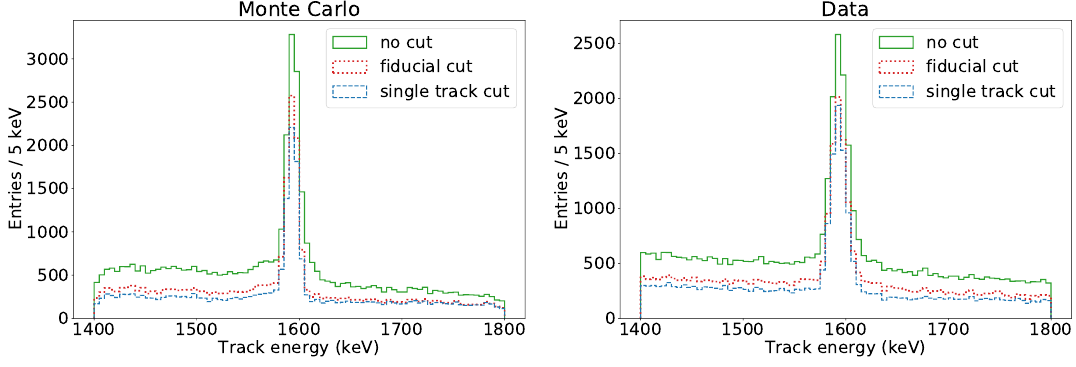
Figure 3 . Distribution of the track energy in the region around the double escape peak before any cut and after the single-track and the (cid:12)ducial cut (see text for details). Left: Monte Carlo, right: